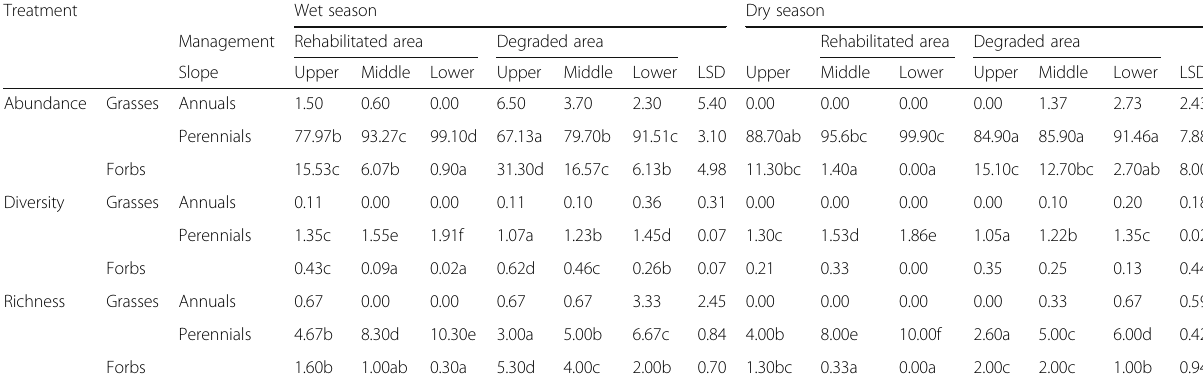
Table 1 Herbaceous species richness, relative abundance (%), and diversity in rehabilitated and degraded areas of Suswa catchment during wet and dry seasons